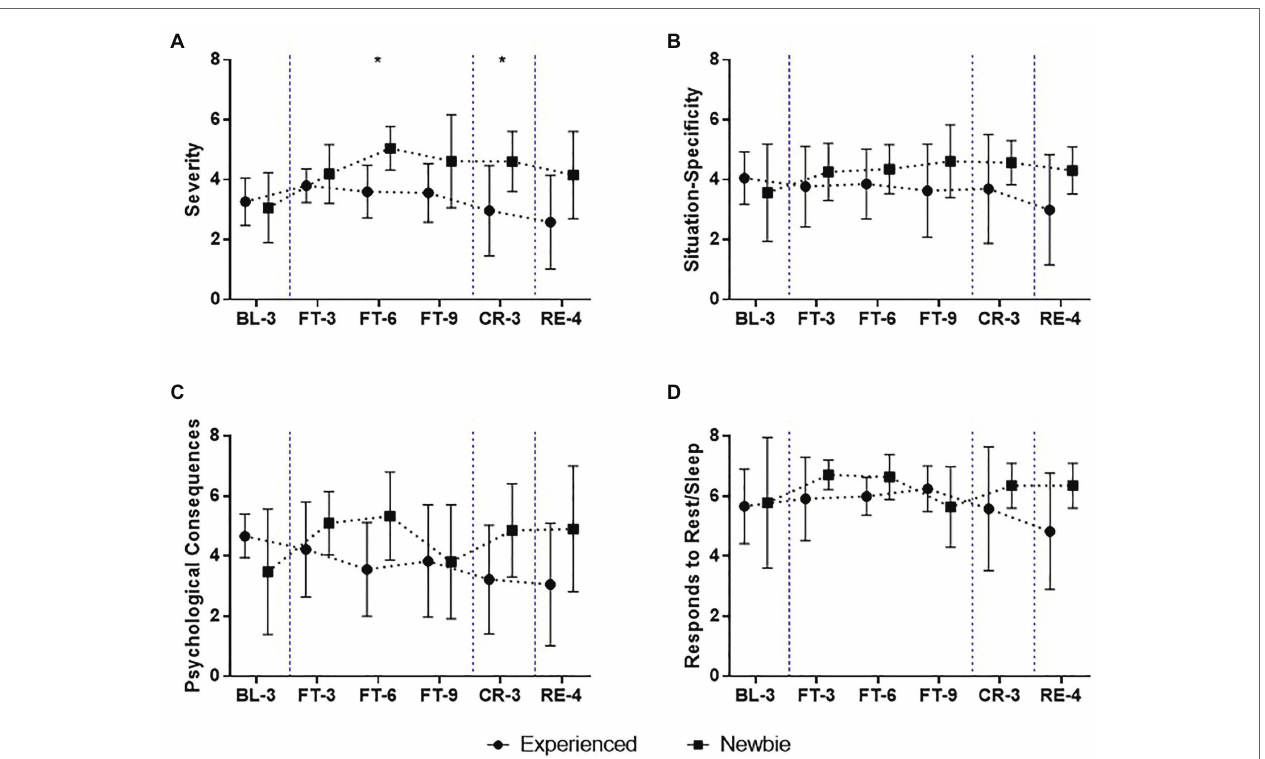
FIGURE 5 | Mean and SD of fatigue scores over the 22-day experiment for the Experienced and Newbie groups. (A-D) The scores of the subscales of the fatigue assessment instrument (FAI). Symbols represent mean scores for the two groups, and error bars represent the SD of the mean. * p < 0.05 indicates significant differences between the two groups at a given test point. Blue dashed lines indicate the different